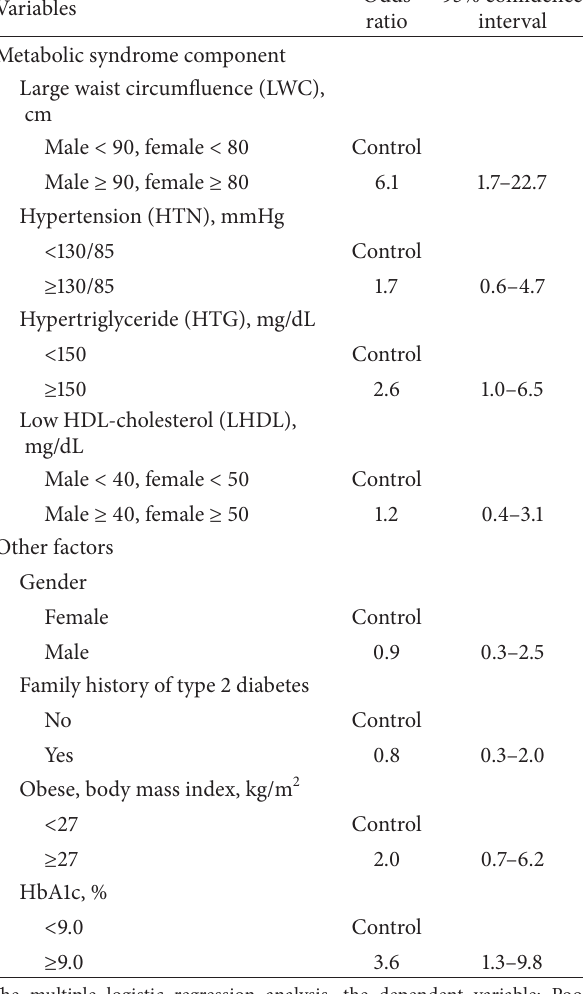
Table 4: Multiple logistic regression analysis for metabolic syn- drome factors and others factor on high HOMA insulin resistance index quartile 4 ( >